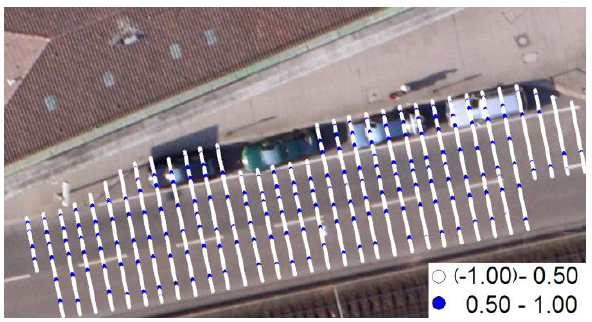
Figure 14. Correlation coefficients of the height